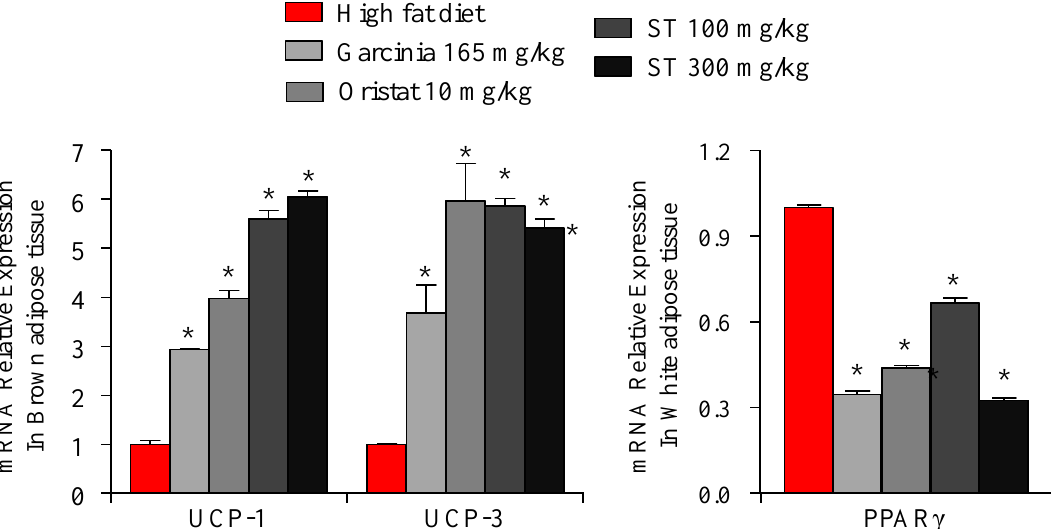
Figure 3. E ff ects of Sargassum thunbergii on the expression of adipogenesis (PPAR γ ) and thermogenic uncoupling protein 1 and uncoupling protein 3 (UCP-1, UCP-3) genes in white adipose tissue and brown adipose tissue. All data was obtained via RT-PCR analysis. Significant di ff erences were identified at * p < 0.05, as compared to the HFD group.